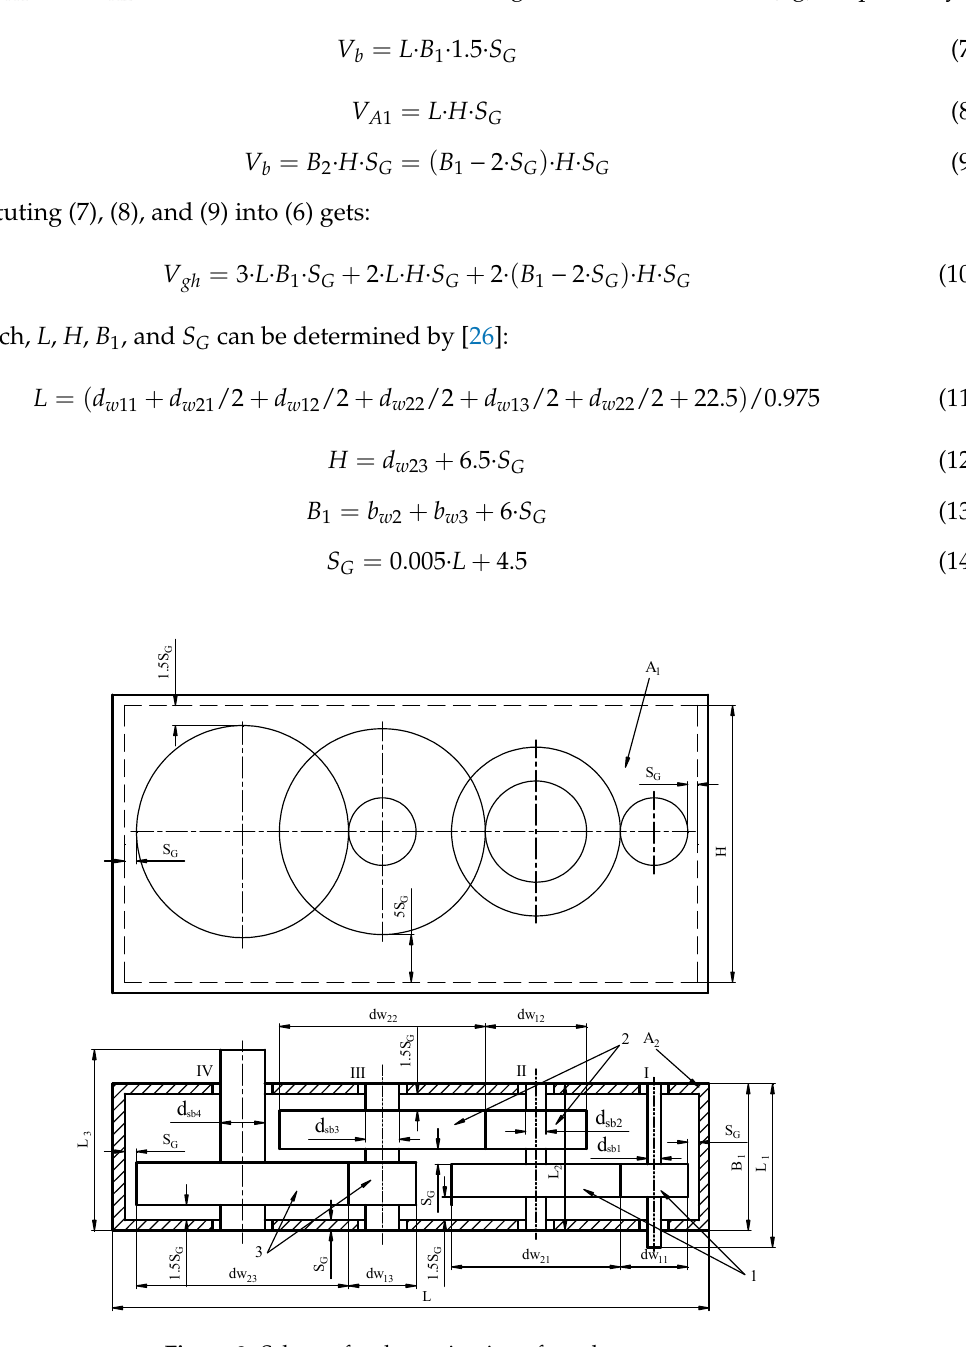
Figure 3. Schema for determination of gearbox mass.